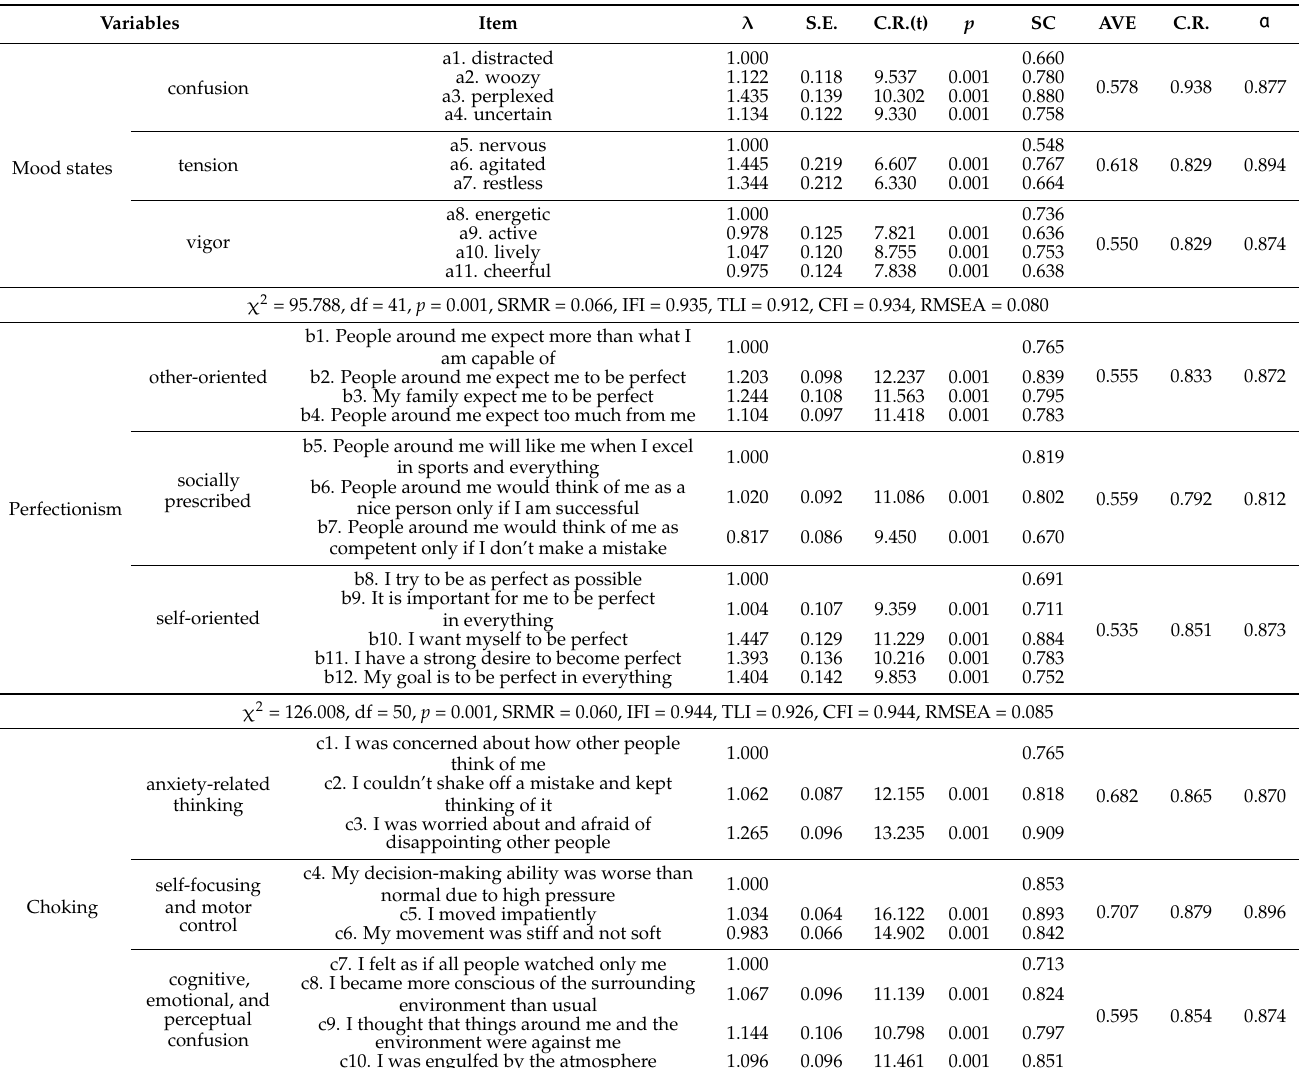
Table 3. Validity and reliability analyses.